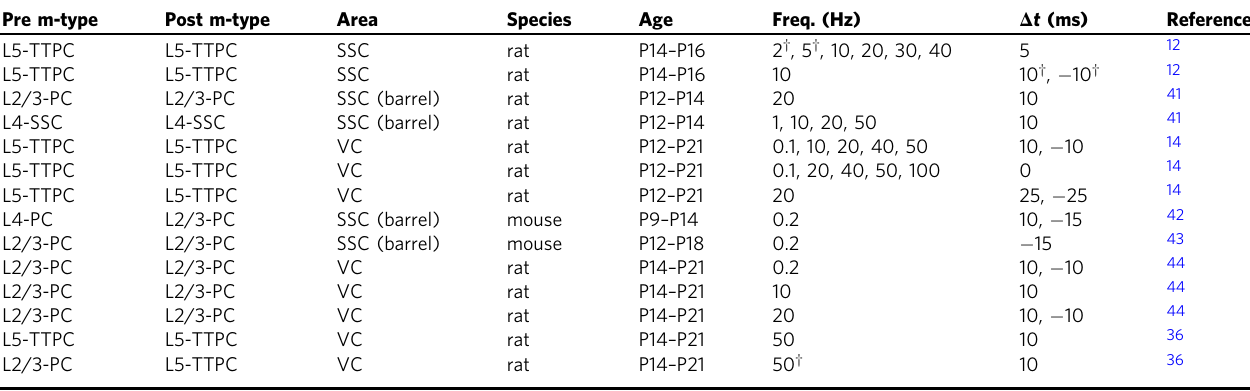
† Stimulation protocol used for model fi